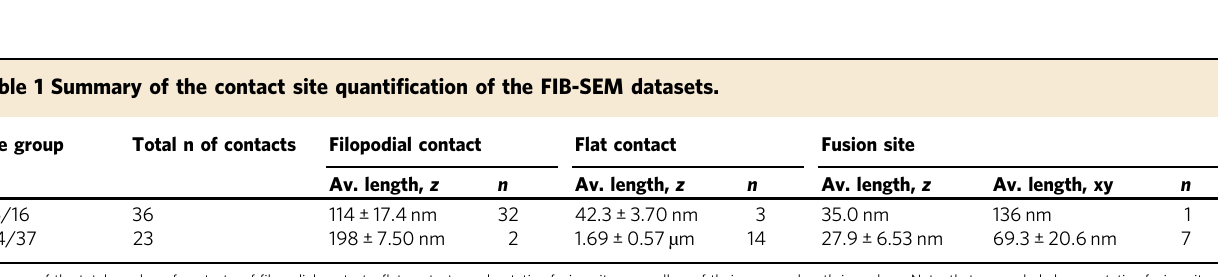
Fig. 6 FIB-SEM and electron tomography indicate close membrane contact sites between neighboring IHCs. a 3D model of a fi lopodial contact in immature (P16) IHCs and a fl at membrane contact in mature (P34) IHCs. Yellow asterisks highlight non-traceable membrane regions. b Example tomographic virtual sections from a high-pressure frozen/freeze-substituted (HPF/FS) P16 sample showing a fi lopodium reaching from one IHC to a neighboring IHC (10 virtual sections in z between two pictures, each section distance of 2.616 nm), arrow points to a vesicle, arrowheads to cytoskeletal fi laments within fi lopodium. c 3D model of the fi lopodium. d Example tomographic virtual section from HPF/FS P34 IHCs depicting a fi lopodium (arrow) between two adjacent cells. The arrowheads indicate the membrane contact. e Further HPF/FS examples showing two virtual sections of fl at IHC – IHC membrane contacts with different extensions in P34. Right panel: Two virtual sections from the same tomogram as in the middle panel. The membranes come very close and cannot be distinguished anymore in virtual section 80 (blue arrowheads), whereas two separate membranes are visible in section 67 (white arrowheads). Independent HPF/FS for electron tomography of each age group = 1; n tomograms (P16) = 1, N animal s = 1, n tomograms (P34) = 12, N = 2. f Schematic illustrating the development of IHC membrane contacts based on the results from FIB-SEM and electron tomography: red circles: animals fi lopodial contacts, black circles: fusion sites, purple circles: purple fl at membrane contacts. In immature organs of Corti, SCs enwrap the IHCs, while mature IHCs are forming extended fl at cell-to-cell membrane contacts. FIB-SEM focused ion beam-scanning electron microscopy, IHC inner hair cell , SC supporting cell. Scale bar: b – e = 200 nm.